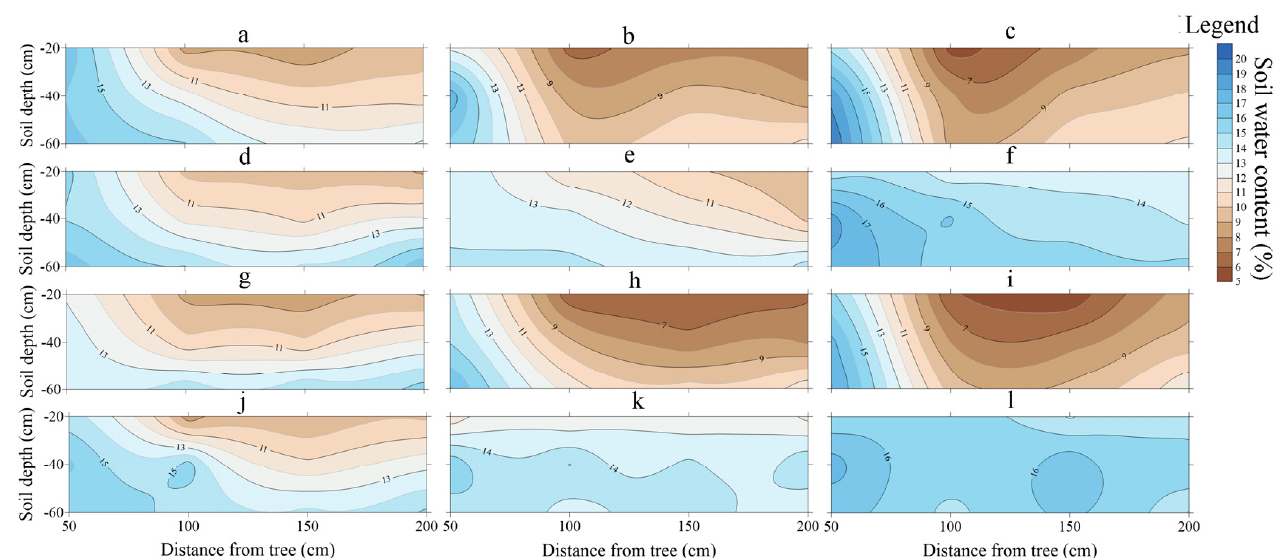
Figure 4. Two–dimensional SWC distribution in different growth stages of MA and AS system. (left: a , d , g , j ) Soybean branching stage; ( b , e , h , k ) soybean flowering-podding stage; (right: c , f , i , l ) seed filling stage; 2020 MA ( a – c ), 2020 AS ( d – f ), 2021 MA ( g – i ), 2021 AS ( j – l ). By comparing the SWC between monocropping and intercropping, we found that the difference between them was mainly at FS and SS. Compared with monocropping, intercropping increased the SWC at T 100 , T 150 , and T 200 by 80.04%, 71.60%, and 43.49% the SWC by 114.91%, 77.64%, and 47.56% at T 100 in different soil layers,